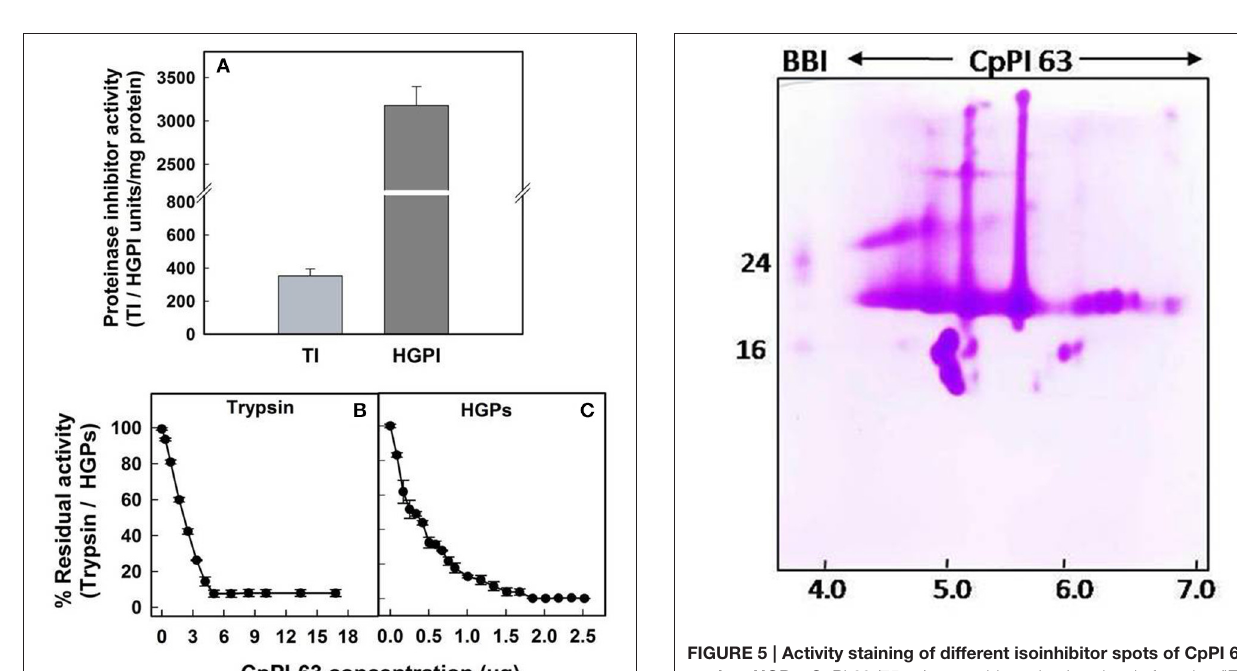
FIGURE 5 | Activity staining of different isoinhibitor spots of CpPI 63 against HGPs. CpPI 63 (75 µ g) was subjected to Iso electric focusing (IEF) under non-reducing conditions as described in materials and methods using pH 4–7, 11cm strips. Second dimension of electrophoresis was executed using gelatin SDS-PAGE (18%). After electrophoresis, the gel was incubated with Triton-x-100 followed by HGPs as described in materials and methods and stained with CBB R250 to visualize the isoinhibitor spots of CpPI 63 active against HGPs. The gel shown here is a selective representative from three replicates of CpPI 63 purified from three independent